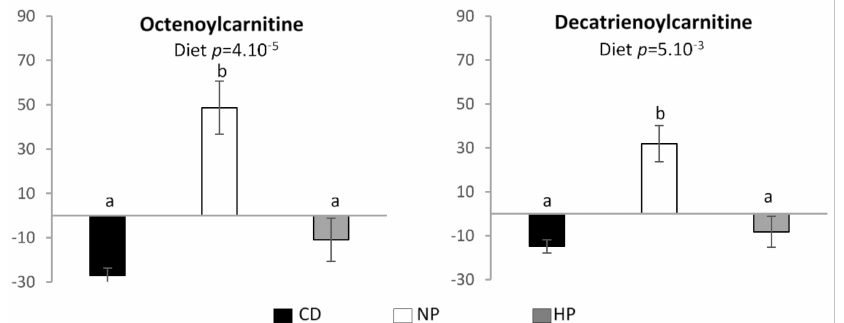
Figure 5. Relative signal intensity of features in urine associated with the NP high-fat hypercaloric diet. Data are mean ± SEM. The p value is indicated on each graph, when the difference is significant, for the diet and period effect (analysis of variance (ANOVA)). When the diet effect is significant, different letters indicate significant differences between groups. CD—control diet; NP—normal